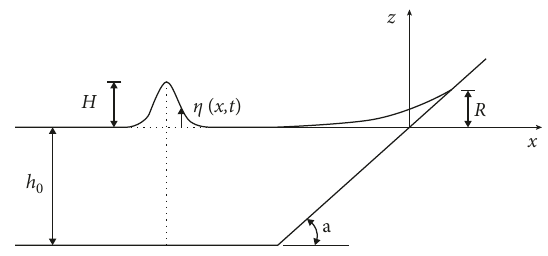
Figure 1: Schematic of wave run-up on a sloped